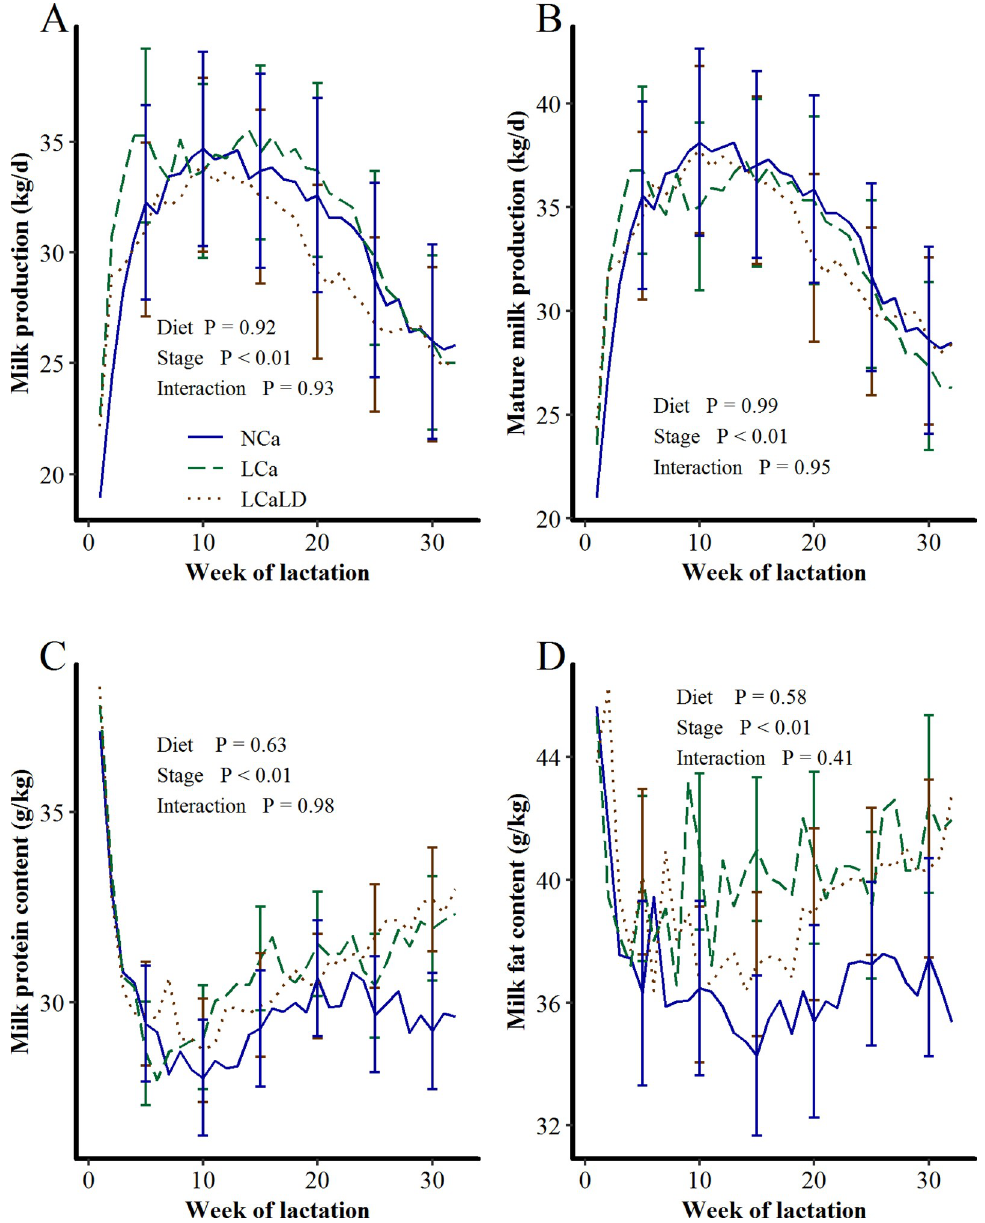
Fig 1. Differences in A) milk production, B) mature equivalent milk production, C) milk protein content and D) milk fat content among cows during the first 32 weeks of the lactation preceding that described in the present paper according to their subsequent treatments. NCa = normal Ca (4 cows), LCa = low Ca (5 cows), LCaLD = low Ca and low DCAD (5 cows). Data were analyzed using a generalized linear mixed model with repeated values using PROC GLIMMIX in SAS[35]. Covariance matrix: SP for milk production, mature milk production, and milk protein content and FA for milk fat content. Vertical bars represent standard errors of the mean. Standard errors are shown every 5 weeks for